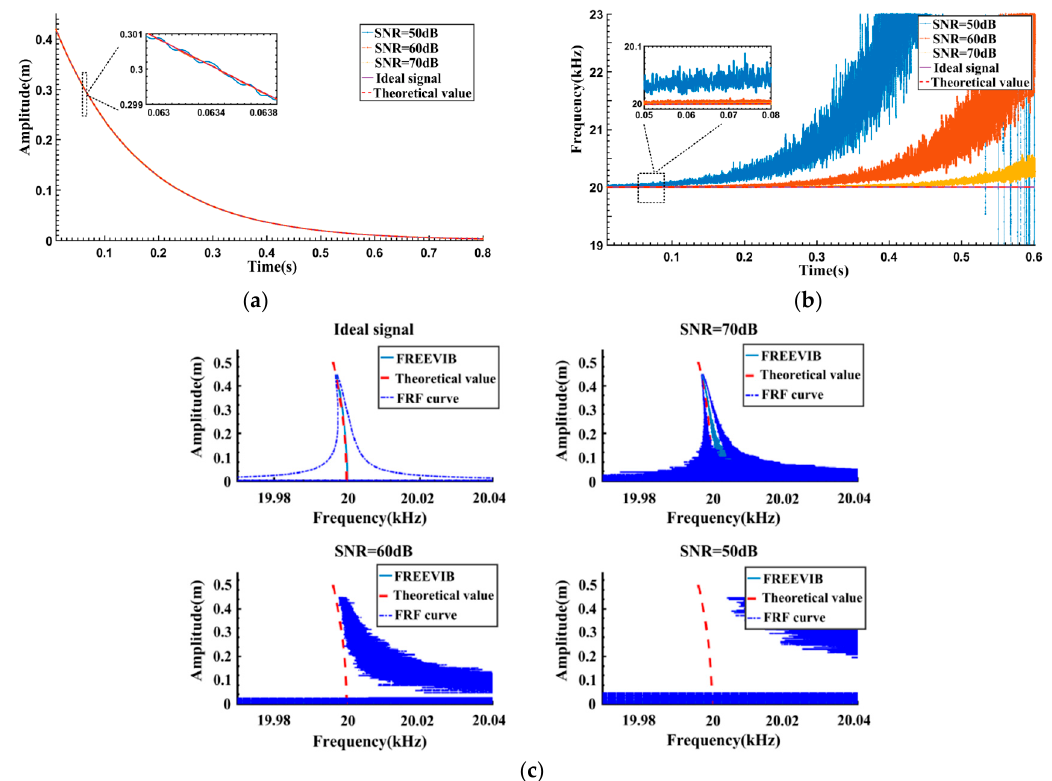
Figure 4. Results corresponding to different SNRs obtained by the FREEVIB method: ( a ) Instantaneous amplitudes (IAs); ( b ) Instantaneous frequencies (IFs); ( c ) Backbone and FRF curves.